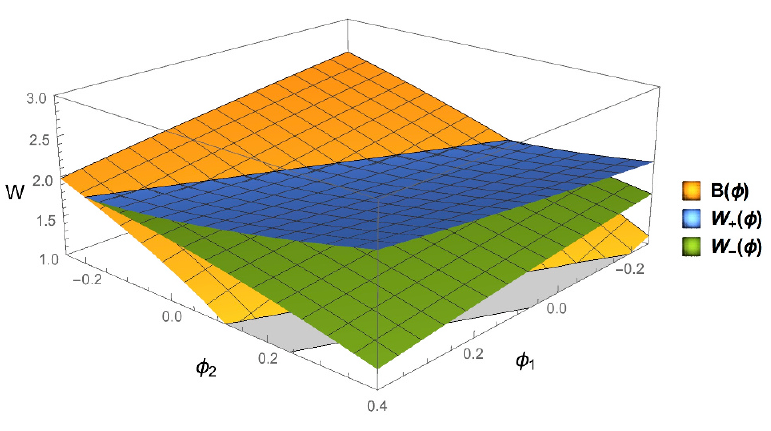
Figure 3 . Two (cid:12)elds | a complete bounce given, to leading order in (cid:30) (cid:0) (cid:30) B , by equation (3.60). The associated vector (cid:12)eld is depicted in (cid:12)gures 4, with the lower (upper) branch in green